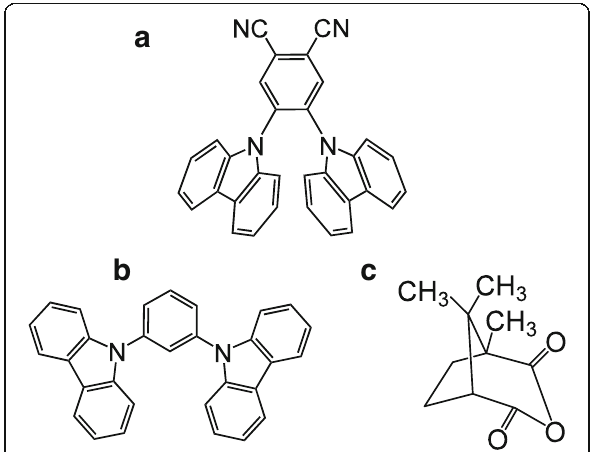
Fig. 1 Chemical structures of a 2CzPN, b m-CP, and c CA